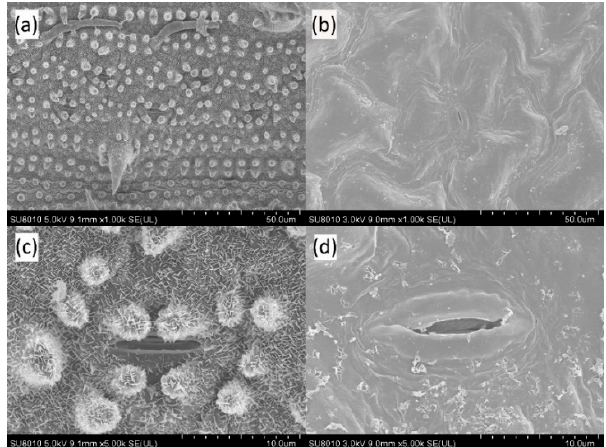
Figure 7. High magnification SEM of rape and rice leaves (adaxial surface): ( a ) rice of 1000 times; ( b ) rape of 1000 times; ( c ) rice of 5000 times; ( d ) rape of 5000 times.